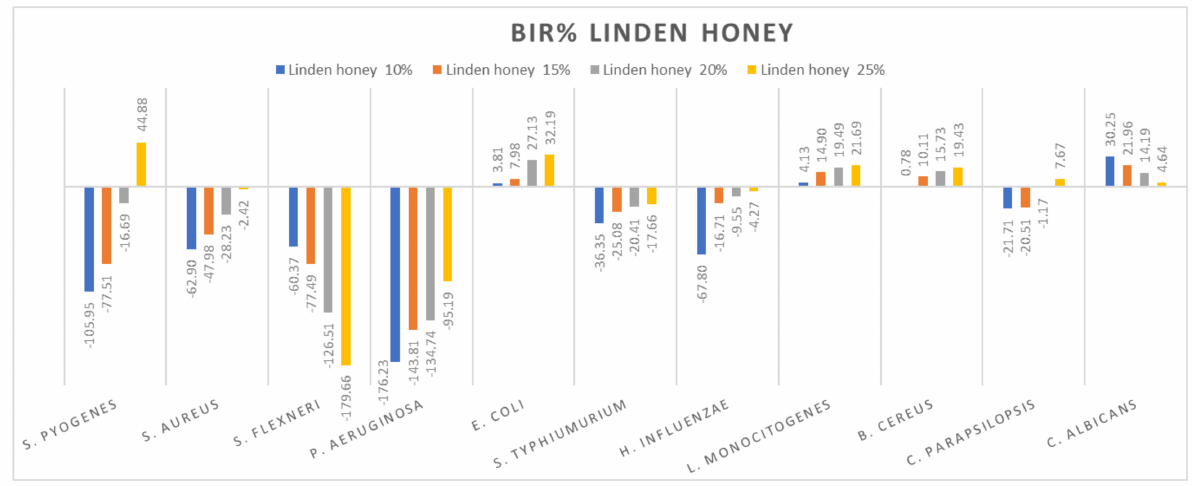
Figure 6. Linden honey antimicrobial activity (expressed as BIR%/MIR%) on ATCC strains. A positive strain-boosting effect but with negative values was recorded in the case of S. aureus , P. aeruginosa , S. typhimurium , H. influenzae and C. parapsilopsis . The inhibition value increased with the increase in concentration, but it did not reach the MIC. Positive inhibitory results were recorded for S. pyogenes at 25% (44.88%), E. coli (32.19%), L. monocitogenes (21.69%) and B. cereus